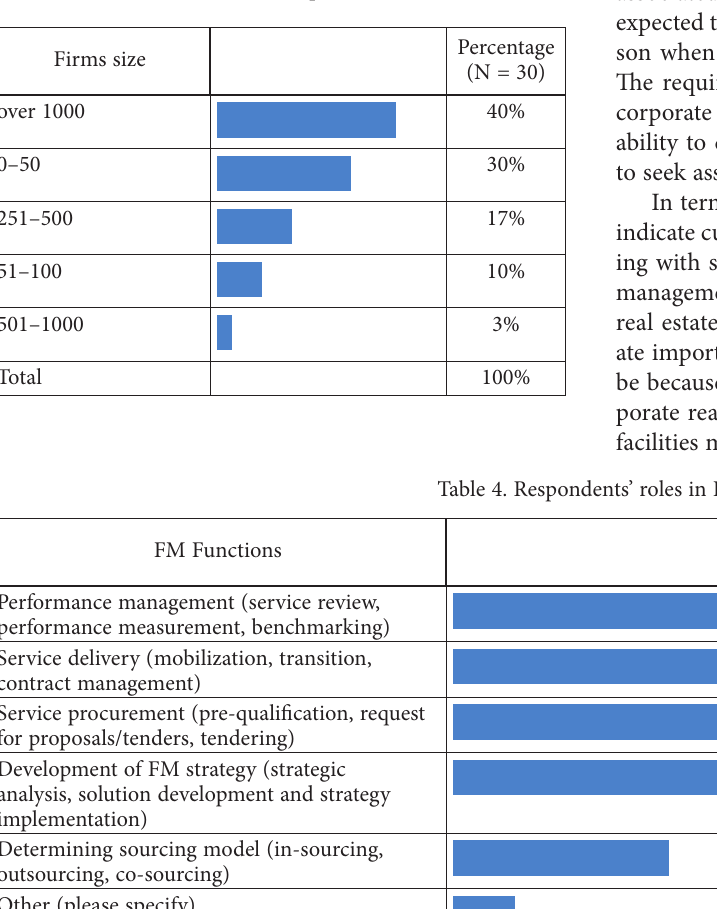
Table 3. The size of respondents’ firms